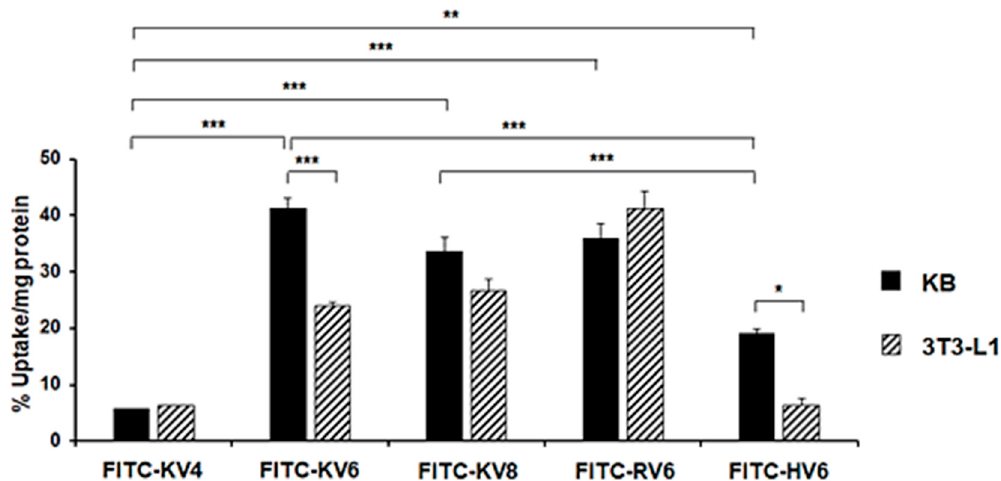
Figure 2. Cellular uptake of FITC-CAPs into KB and 3T3-L1 cells at 2 h post-incubation. * p < 0.005, ** p < 0.0005, and *** p < 0.0001 (ANOVA and Tukey’s t test). Values are means ± SEM; n = 7–13.